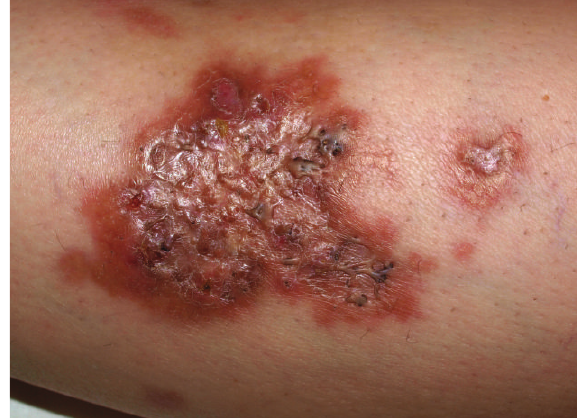
Figure 2: Close view of an irregularly shaped brown-yellow plaque with comedo-like papules.